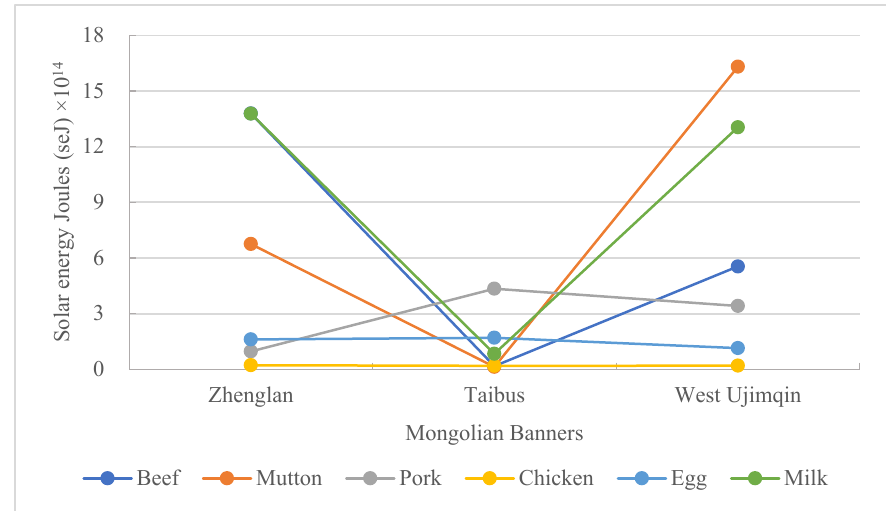
Figure 3. A comparison of animal-based food consumption in the three banners. The characteristics of plant-based food consumption in the three banners were different from those of animal-based food consumption. From north to south, total consumption of plant-based foods increased further south. Plant-based food consumption in Taibus banner came to 5.38 × 10 14 seJ, which was much higher than that in other two banners, by about 50% (Figure 4). However, there was only a small difference in plant-based food consumption between the other two banners—only 1.28%. As to specific plant-based food consumption, such as of rice, millet, vegetables, and fruits, the consumption in West Ujimqin banner was the greatest when compared with the other two banners. The greatest consumed quantities of rice, millet, vegetables, and fruits were 373.88%, 339.79%, 52.17%, and 108% higher, respec- tively, than those least consumed across the banners. The consumption of wheat, oats, and oilseed increased further south, with the greatest consumption of these three kinds of food appearing in Taibus banner, and the least appearing in West Ujimqin banner. The greatest consumed quantities of these three kinds of food were 1.01-fold, 16.43-fold, and 1.49-fold higher, respectively, than the least consumed quantities across the banners.